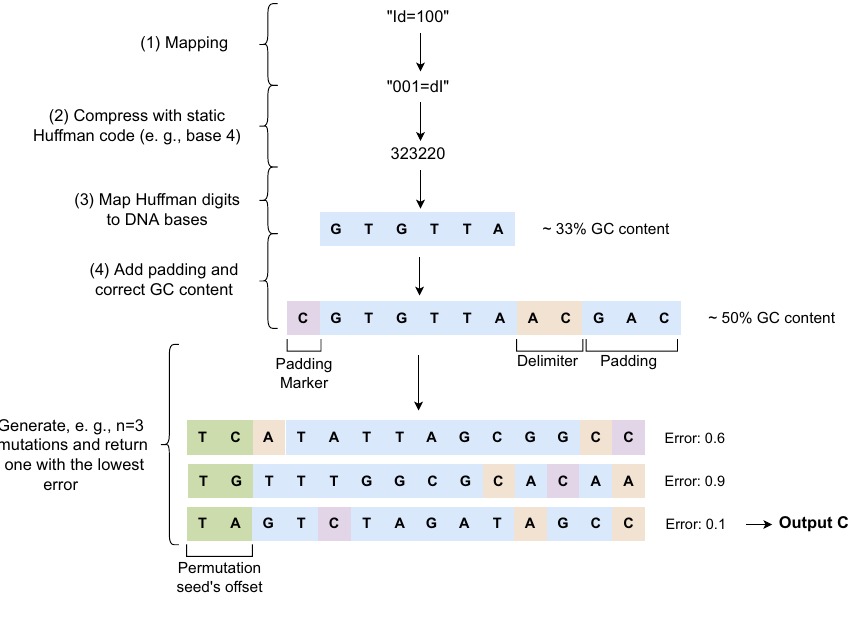
Figure 4. Encoding information as a